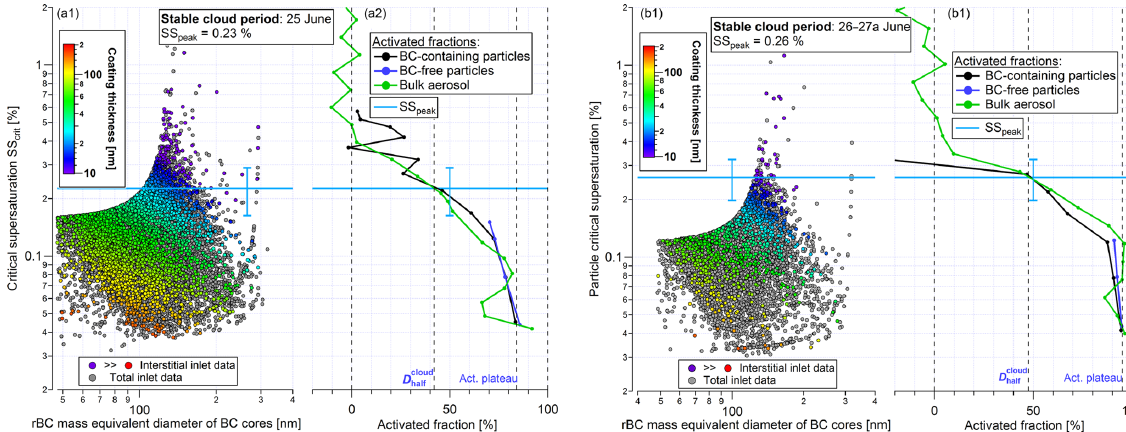
Figure 11. Activation of BC-containing and BC-free particles during the 25 June (a) and 26–27a June (b) stable cloud periods. Panels (a1) and (b1) show the critical supersaturation of individual BC-containing particles as a function of rBC mass equivalent diameter coloured by coating thickness for the interstitial inlet and in grey for the total inlet. Note that the coating thickness can only be determined for BC-containing particles with an overall diameter greater than 180nm, which explains the missing data points in the top left part of panels (a1) and (b1) . Panels (a2) and (b2) depict the corresponding activated fraction of BC-containing particles as well as that of BC-free particles (SP2-derived) and bulk aerosol (SMPS-derived). Only one-fourth of the data points is shown in panel (a1) in order to visualize the fraction of points originating from interstitial inlet data compared to points from the total inlet data. Horizontal light blue lines indicate the value of SS peak retrieved using D cloud (method explained in Sect. 3.5). Note that values of SS peak for both cases (a) and (b) are at a level above half which the SP2 detects only almost bare BC because small cores with substantial coating are outside the detection limits of the